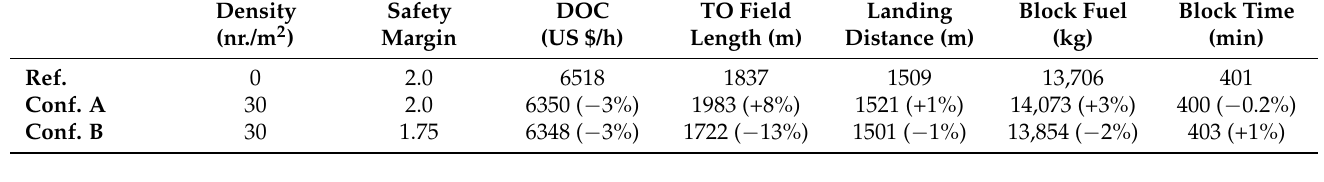
respect to Ref. configuration (see [1]) and the new reference, herein, named Conf. A (configuration